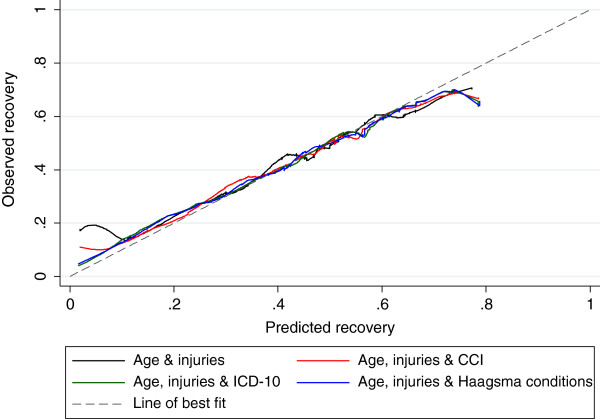
The figure is a plot the predicted versus the observed recovery in the test dataset. The 45° line represents perfect fit of the model.